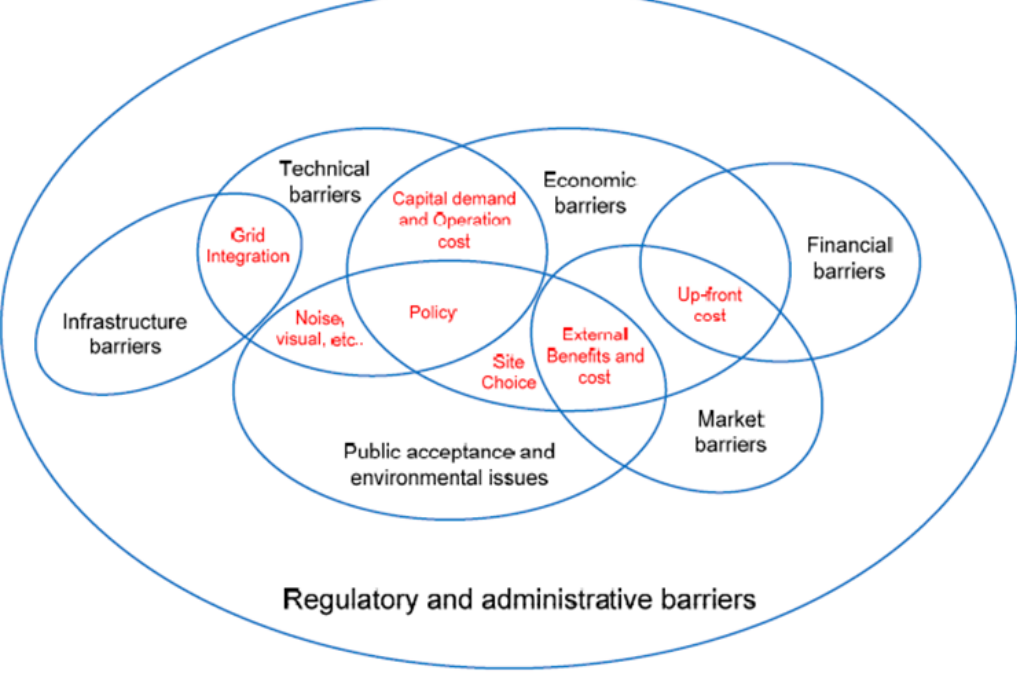
Figure 6. Development barriers for microgrid renewable energy